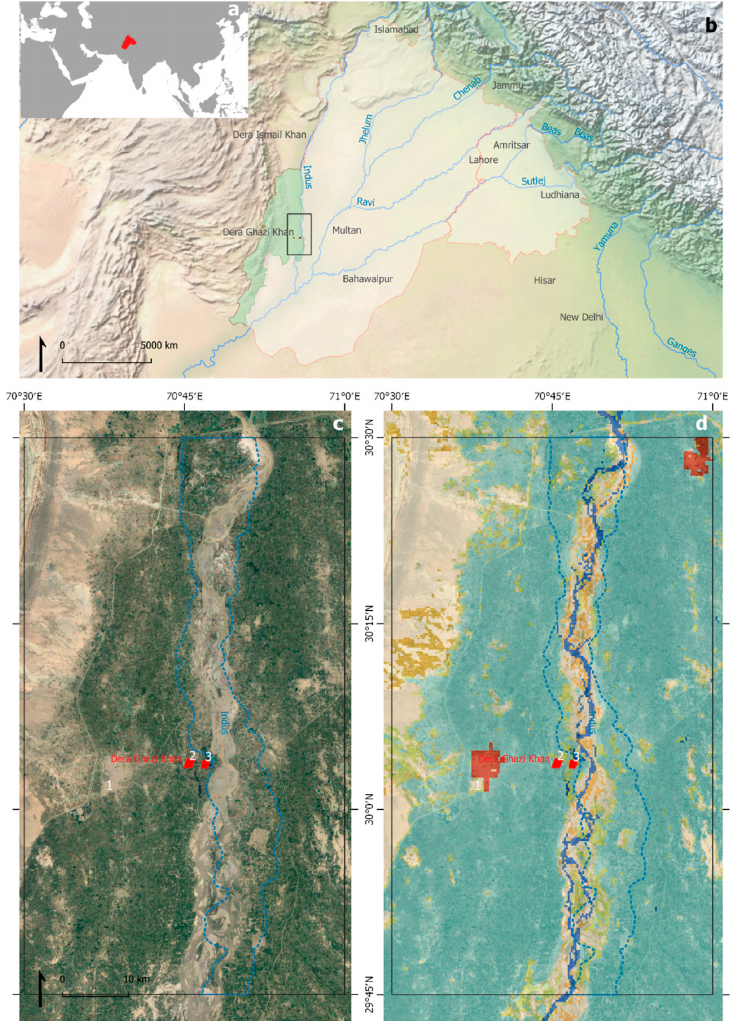
Figure 1. Situation and context of the AOI: ( a , b ) DG Khan district in the context of the moderns Punjab Province (Pakistan) and Punjab State (India); ( c ) actual aspect of the AOI and situation of the DG Khan modern city (1), historical town (3) and nineteenth century British cantonment (2). The dotted line represents the active floodplain of the Indus as it was in 1907; ( d ) actual land-cover classification (GLOBCOVER V. 2.3, 2009) show the area occupied almost entirely by irrigated croplands, except in the riverbed and mountain slopes.